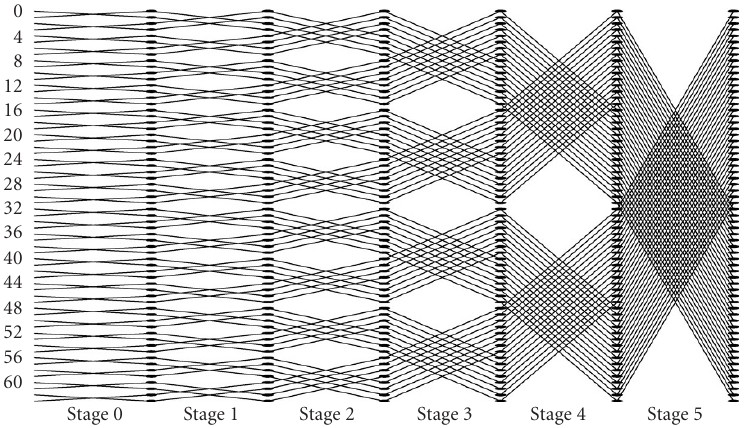
Figure 1: Traditional FFT dataflow diagram.